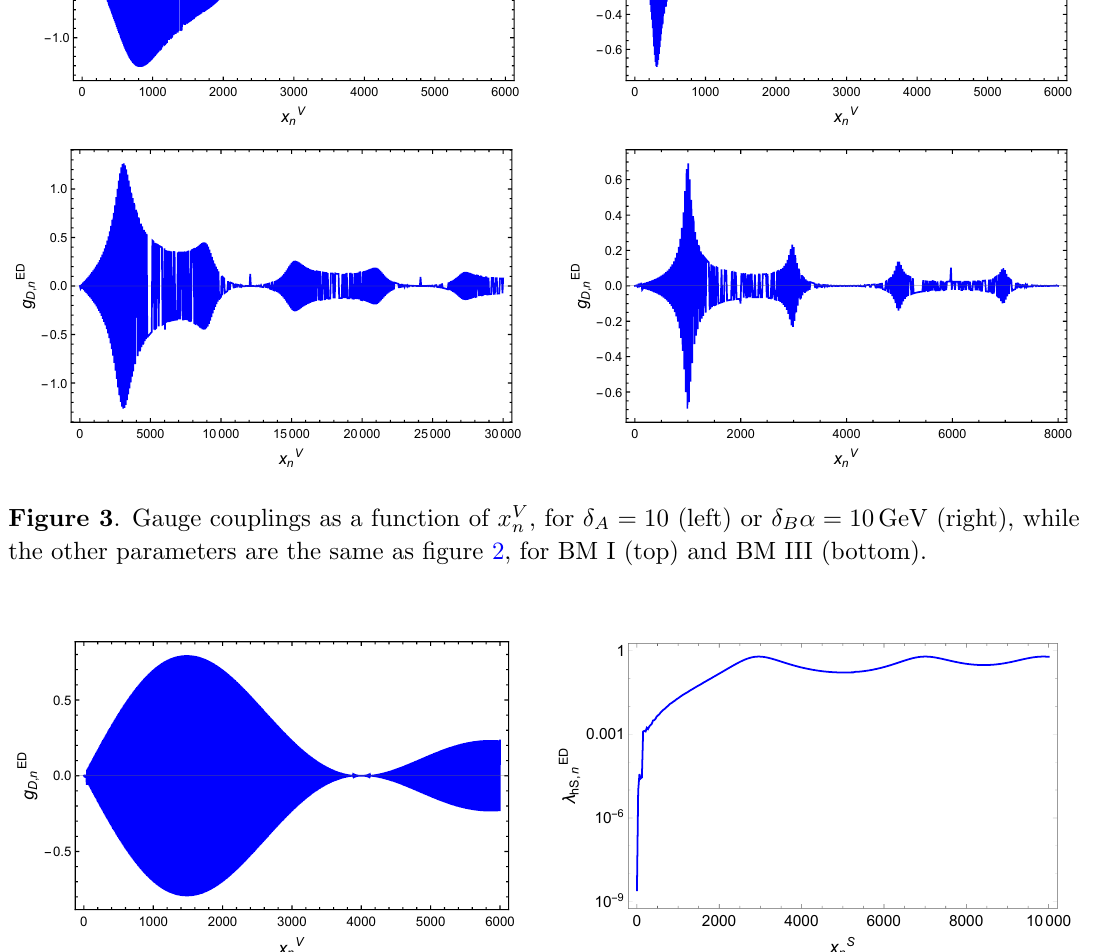
, for (cid:14) B (cid:11) = 10 (cid:0) 2 MeV, while n